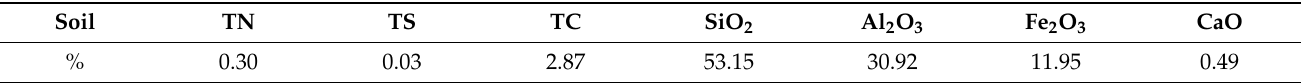
Table 1. Basic properties of the red soil colloids